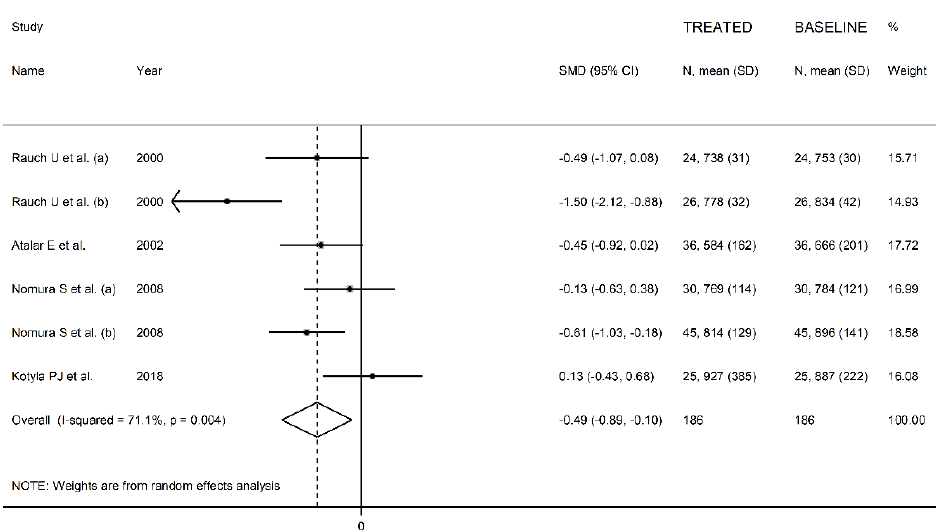
Figure 9. Forest plot of L-Selectin concentrations before and after statin treatment.